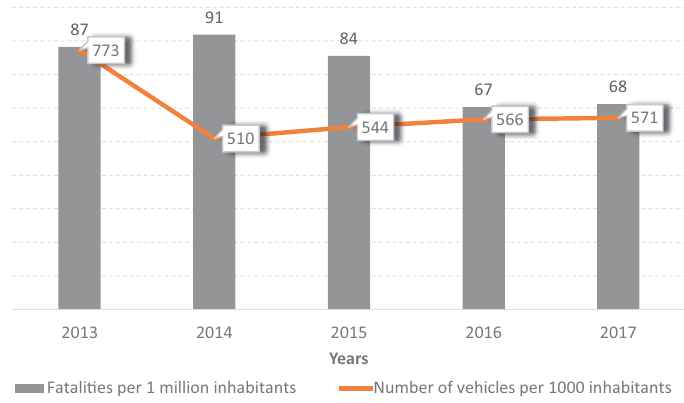
Figure 1. Number of vehicles and fatalities in 2013−2017 (Lithuanian Road Administration…,